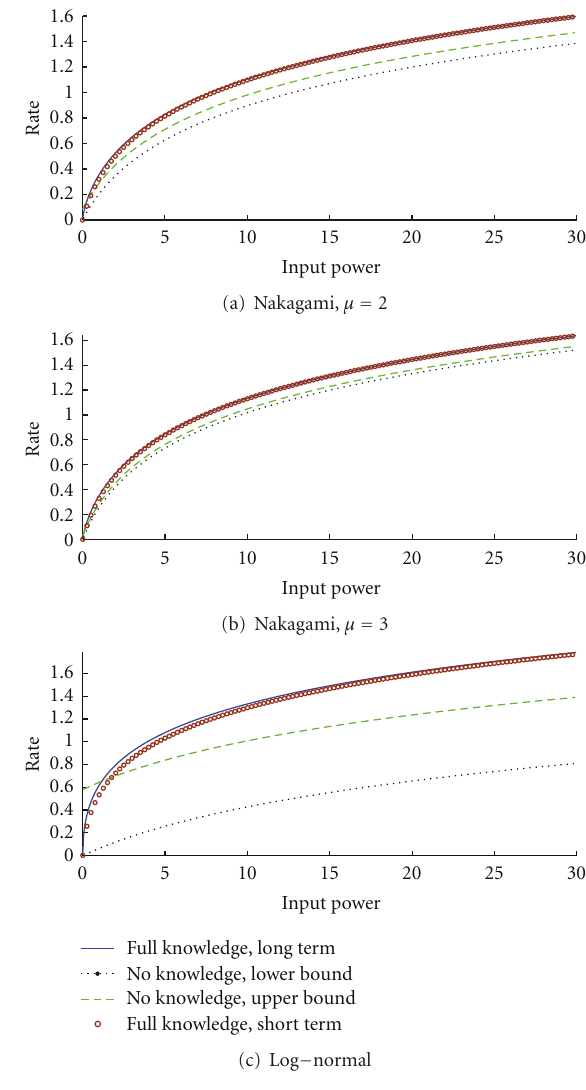
Figure 2: Channel capacity for the three distributions in two full and no knowledge cases. w = 1, γ =